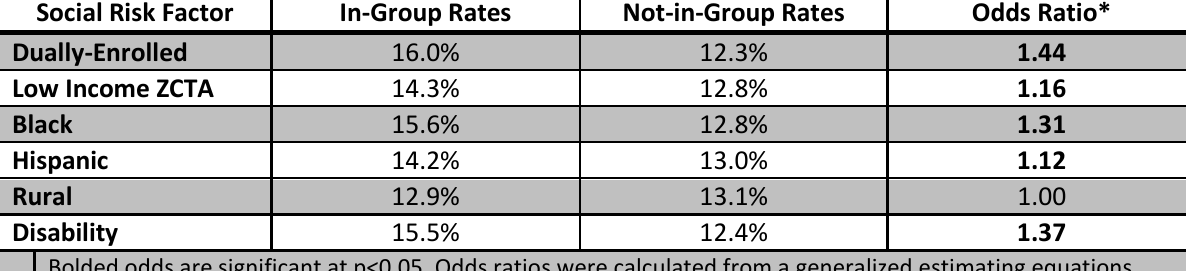
Table 13.3: Beneficiary-Level Social Risk Factors and Re-Hospitalization Rates, FYs 2012-2014